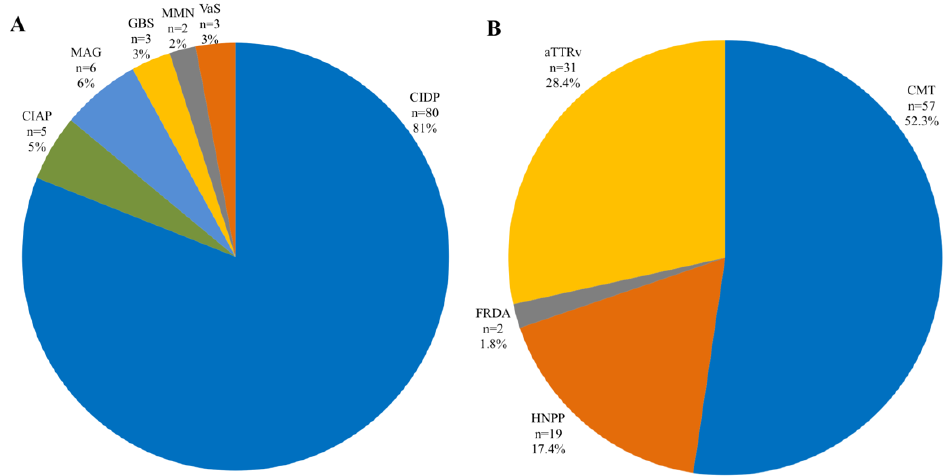
Figure 1. Recruitment procedure according to study’s inclusion criteria. Chronic inflammatory demyelinating polyneuropathy (CIDP) and Charcot–Marie– Tooth (CMT) were the most common neuropathy subtypes (Figure 2).